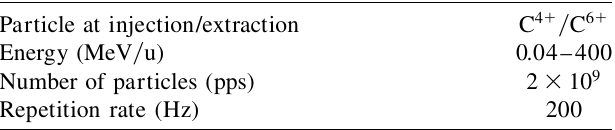
TABLE I. FFAG basic parameters. Particle at